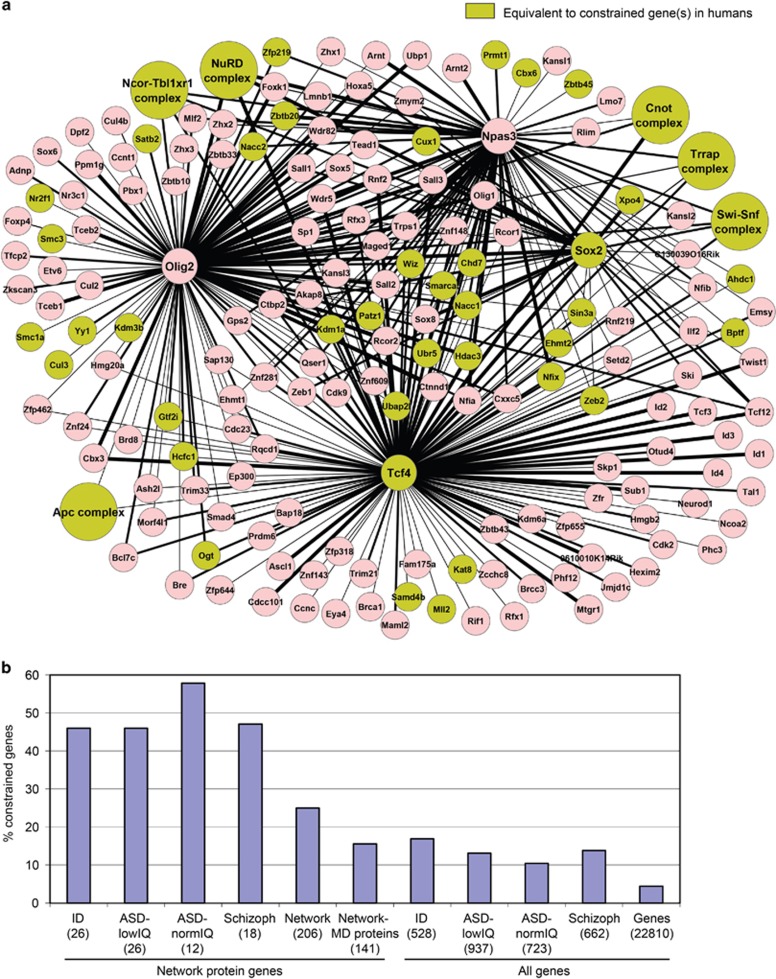
Overlap protein interaction network with constrained human genes. (a) Protein interaction network in neural stem cells. Green color indicates overlap of network protein or protein complex subunit(s) with a set of 1003 constrained genes in humans. (b) Percentage overlap of the indicated categories with constrained genes. Between brackets is the number of human genes equivalent to network proteins in each category (network protein genes) or total number of genes in each category (all genes). ASD, autism spectrum disorder; ID, intellectual disability; IQ, intelligence quotient; MD, mental disorder.